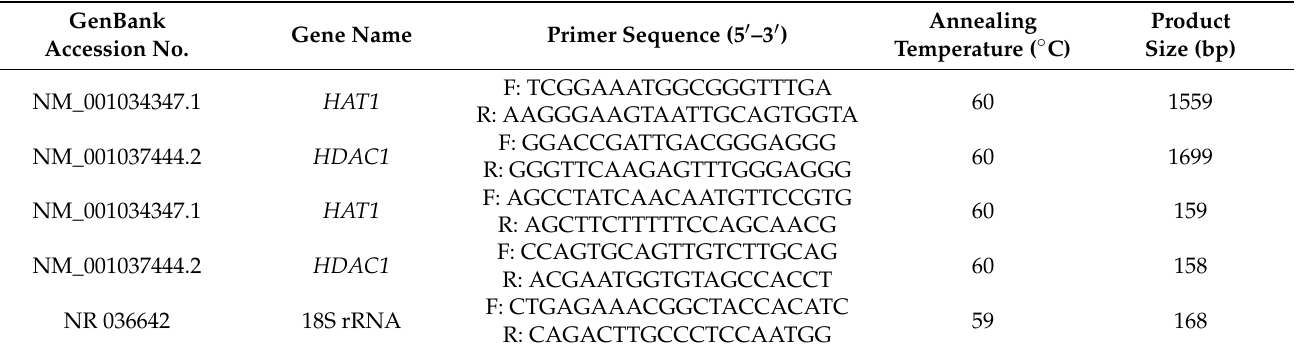
Table 1. Primer information in this